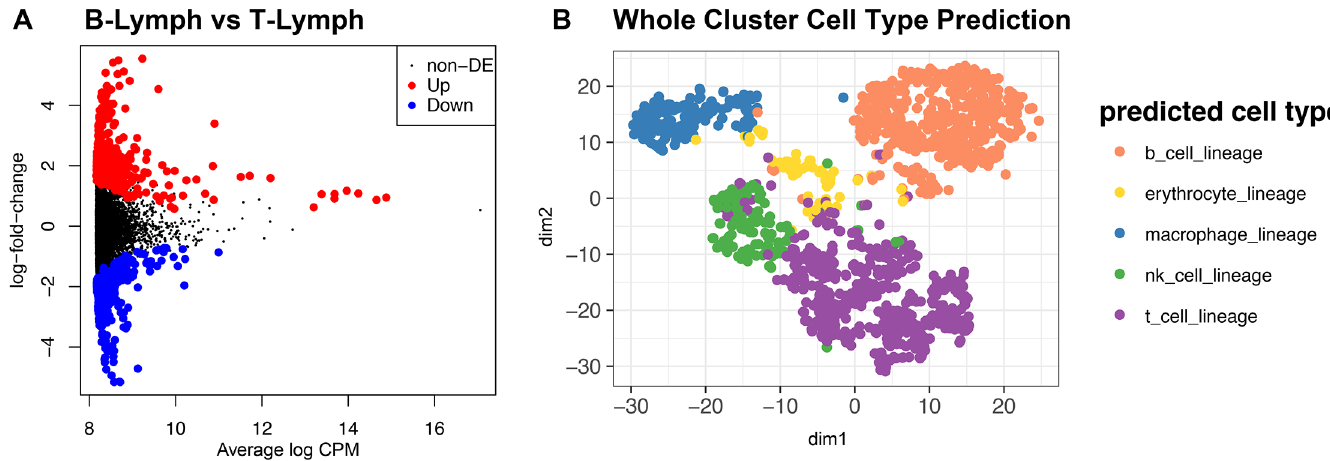
Fig 5. Analysis results produced with SingleCellExperiment -compatible packages from Bioconductor. ( A ) Differential gene expression results from comparing B- lymphocytes and T-lymphocytes known a priori in the CEL-seq2 mouse blood dataset. Highlighted points are genes determined to be significantly differentially expressed from LRT with 0.05 FDR cutoff. ( B ) tSNE coloured by cell type predictions obtained for SC3 clusters for the first spleen sample from the Human Cell Atlas ischaemic sensitivity dataset. The 10 clusters from SC3 were assigned to 5 distinct cell types from the reference set of 12 lineages.